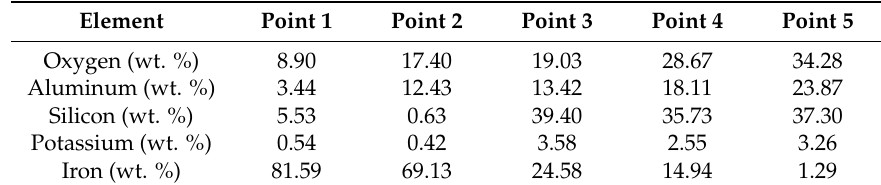
Table 10. Point analysis for the sample E25P2.